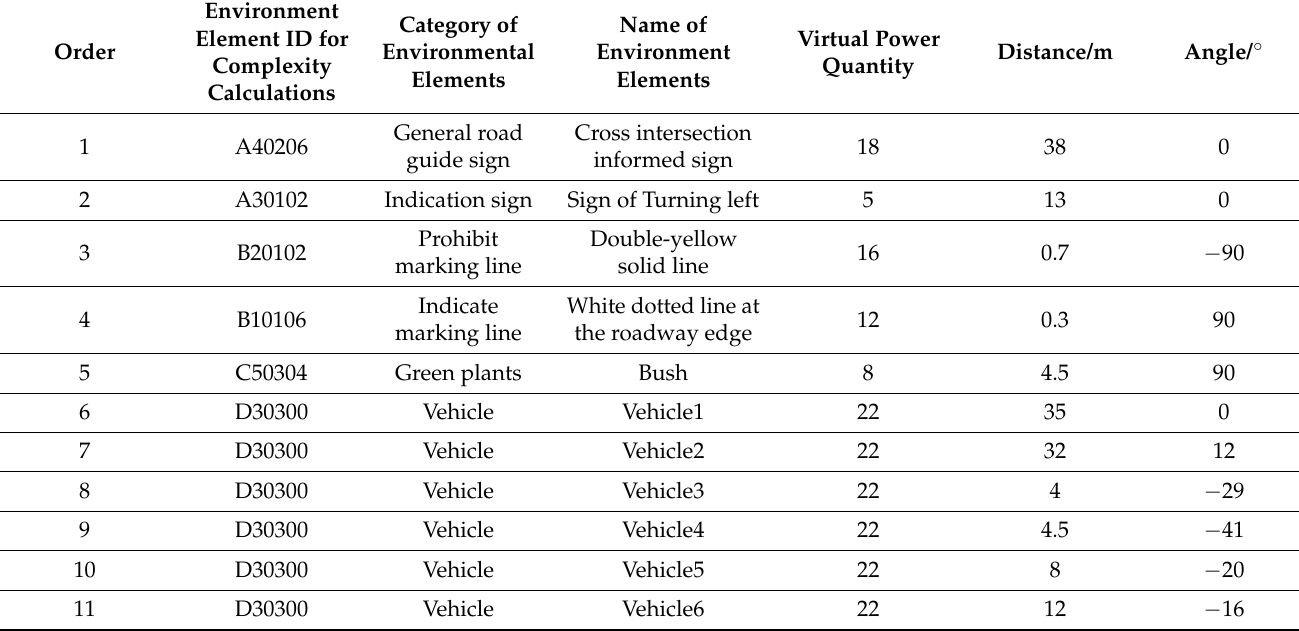
Table 3. The environmental element information parameters and the element ID of the complexity